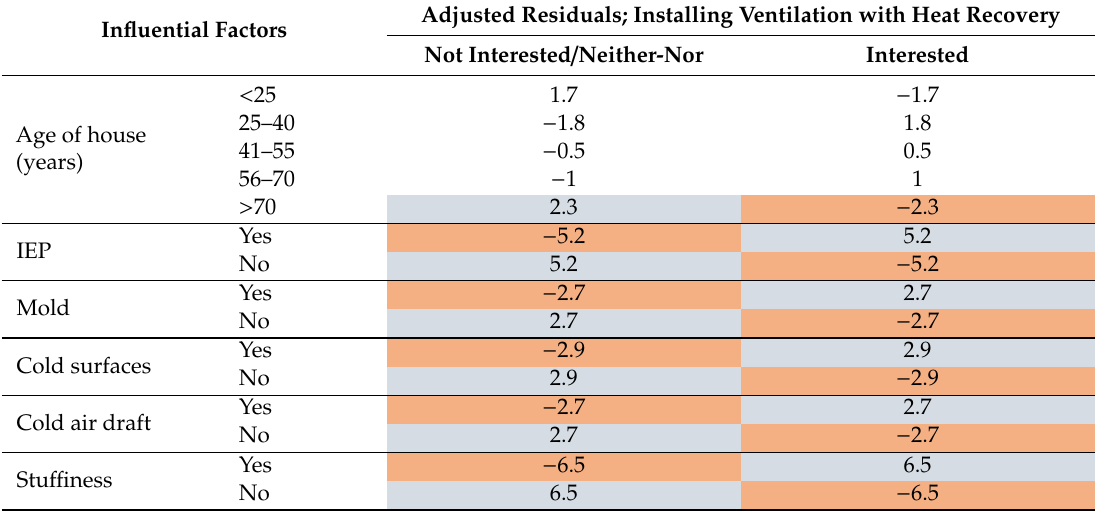
Table A3. Post-hoc analyses of influential factors on homeowners’ interest to install ventilation with heat